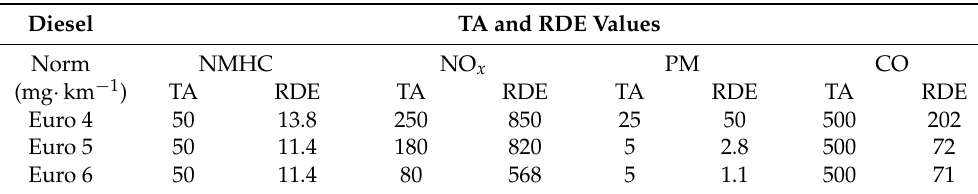
Table 3. Overview of the type approval (TA) values and applied real driving emission (RDE) values for the regulated pollutants for petrol cars. Notice an increased NO x and PM emission for the Euro 6 petrol cars due to the increased implementation of direct injection technology (based upon [21,39,43,54–57]). Petrol TA and RDE Values Norm NMHC NO x PM CO (mg ¨ km ´ 1 ) TA RDE TA RDE TA RDE TA RDE Euro 4 100